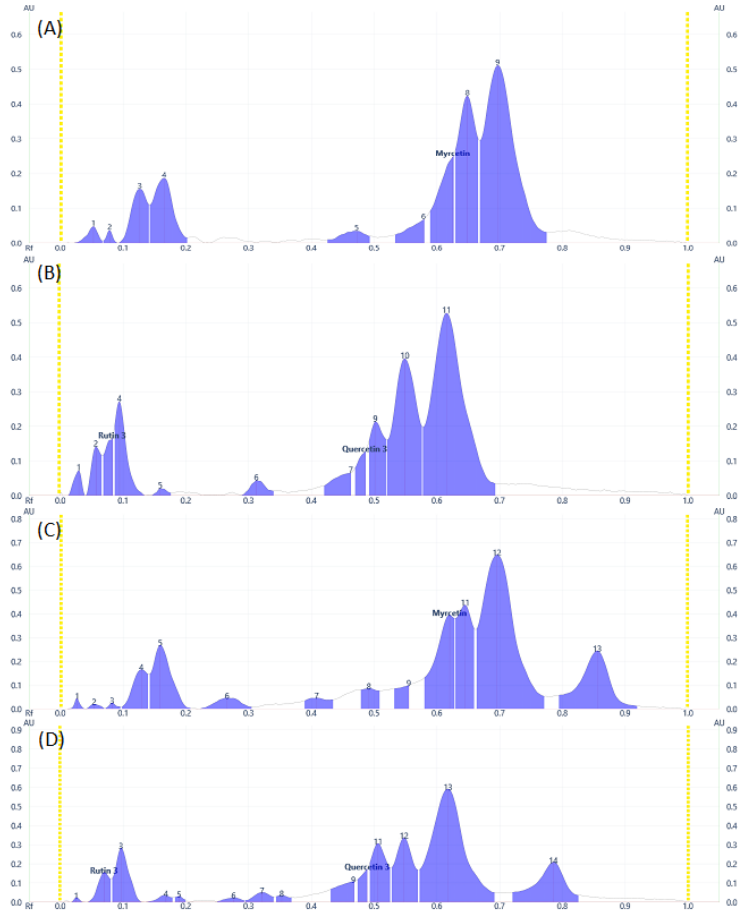
Figure 3. Flavonoids Profile of samples at 366 nm for ( A ) and ( B ) DAF, ( C ) and ( D ) DAL samples.